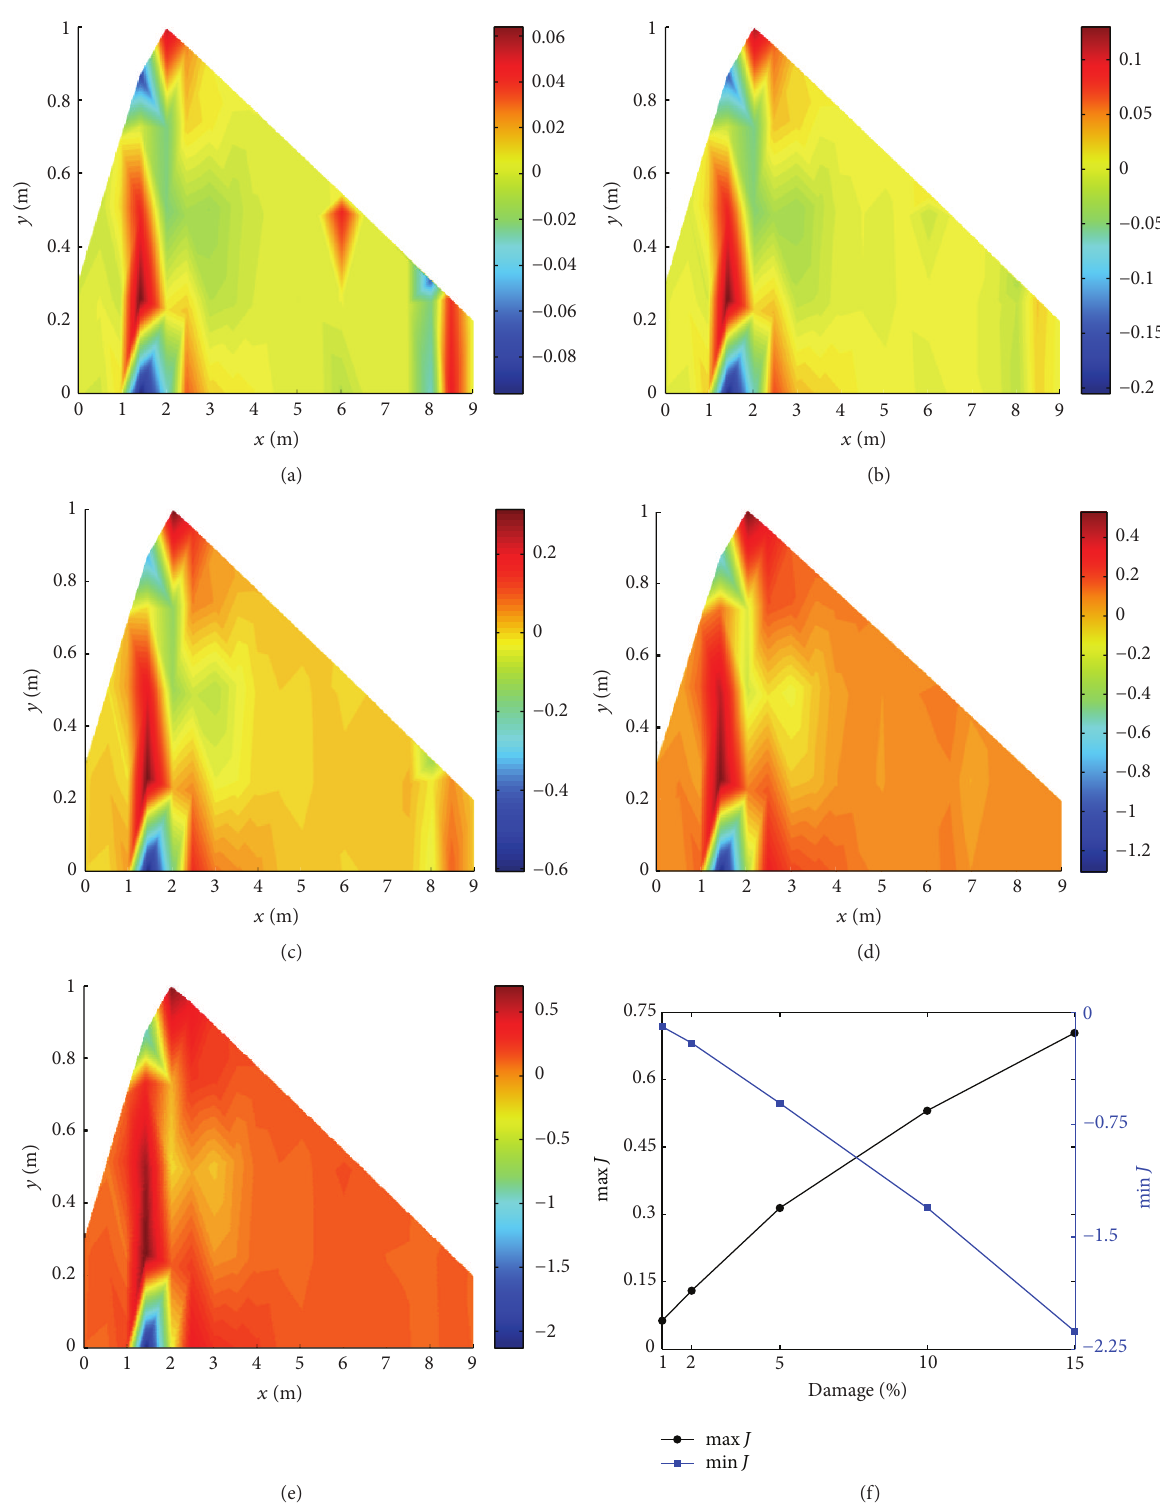
Figure 7: Damage maps 𝐽 for damage cases corresponding to (a) 1%, (b) 2%, (c) 5%, (d) 10%, and (e) 15% reduction in the first natural frequency of the